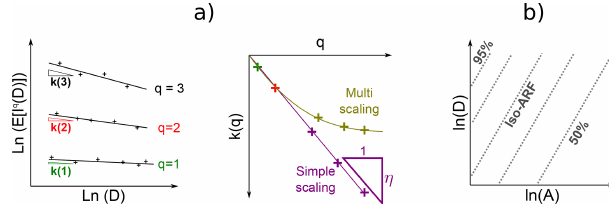
Figure 2. Visual model checks: (a) simple scaling; (b)